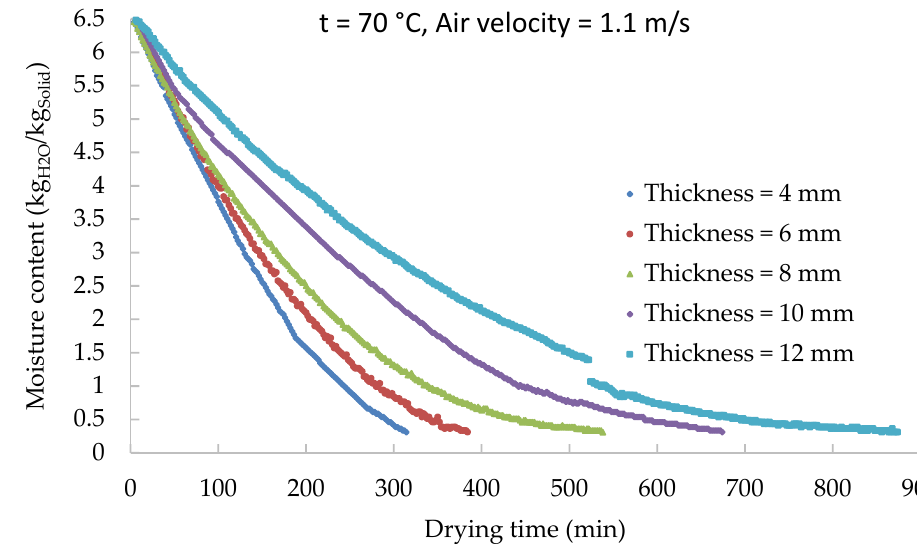
Figure 6. E ff ect of slice thickness. Figure 6. Effect of slice thickness.